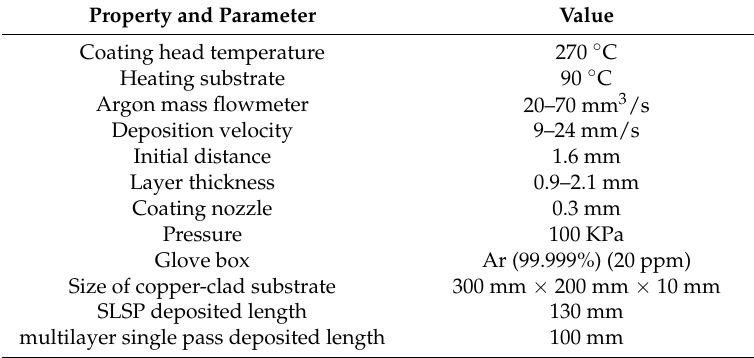
Table 1. Experimental condition of micro-coating metal additive manufacturing (MCMAM).